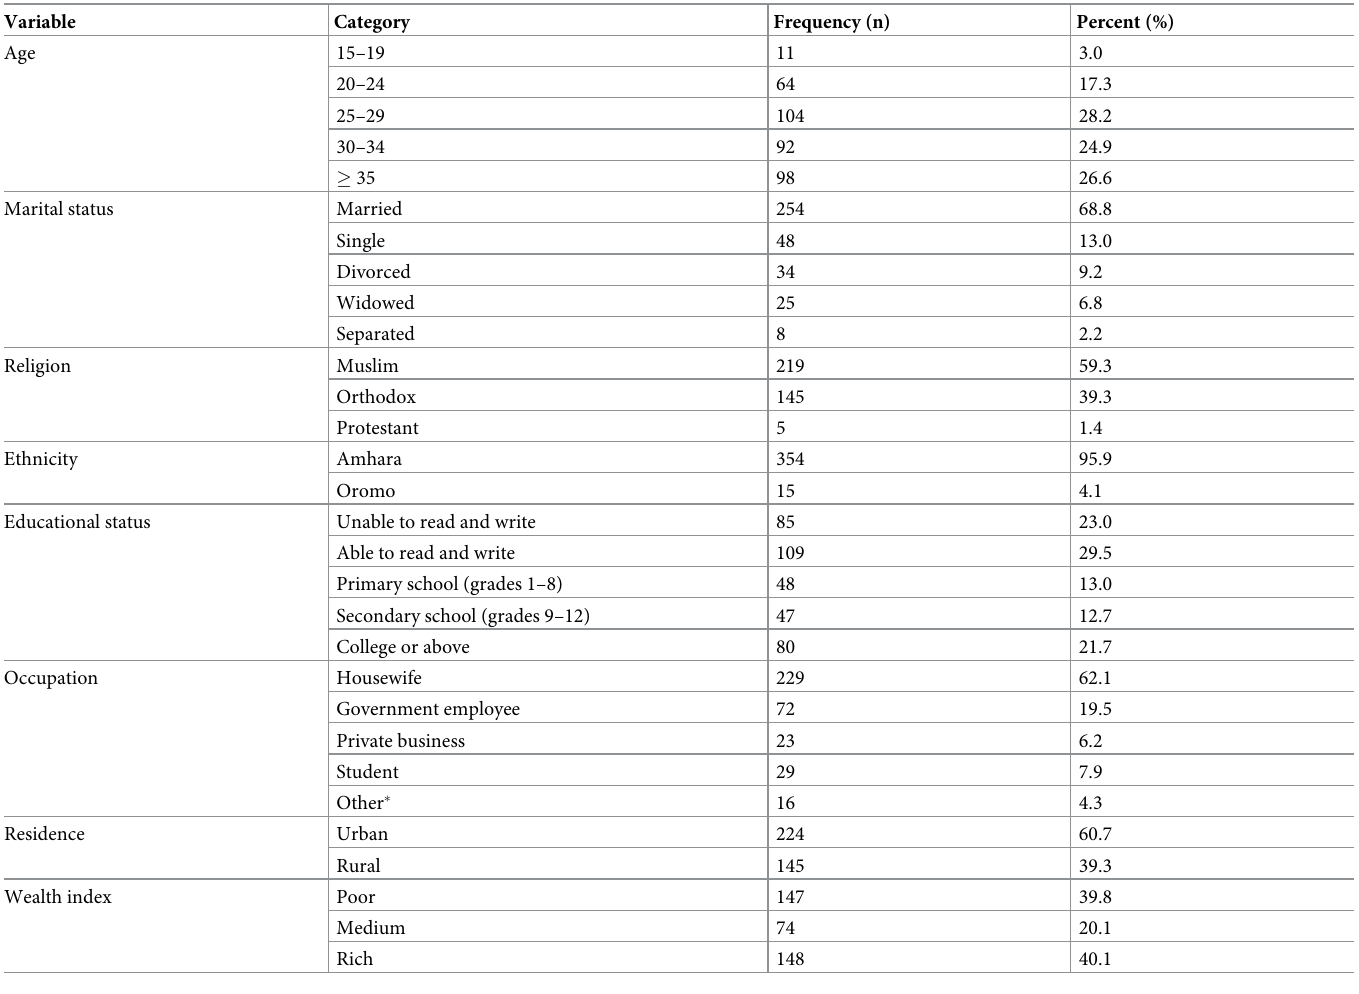
Table 1. Socio-demographic characteristics of participating women in Borena District, Amhara Region, Ethiopia, 2020 (n =